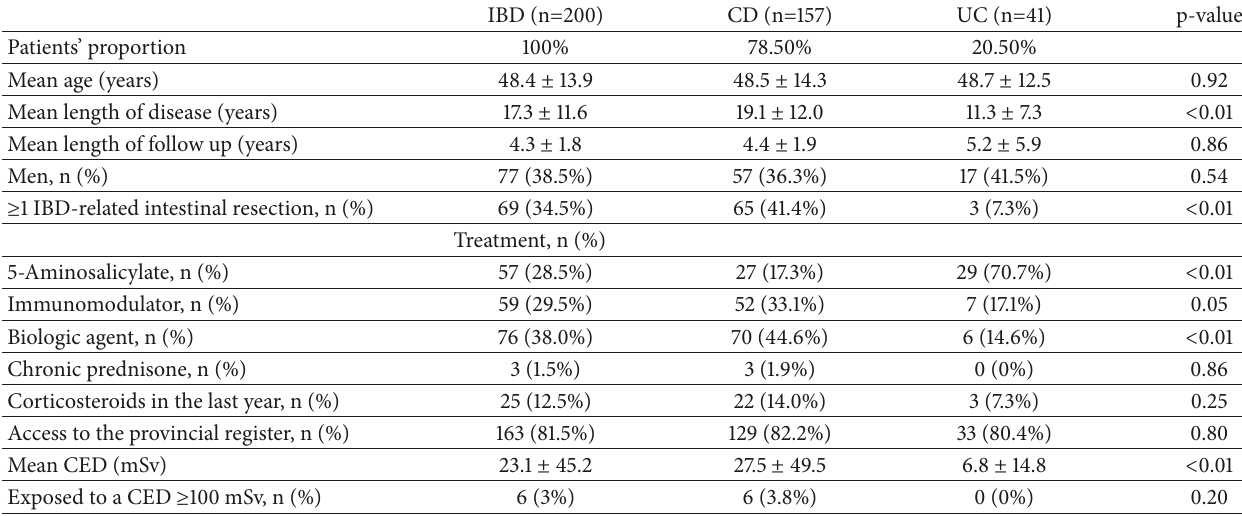
Table 2: Patients and disease characteristics.